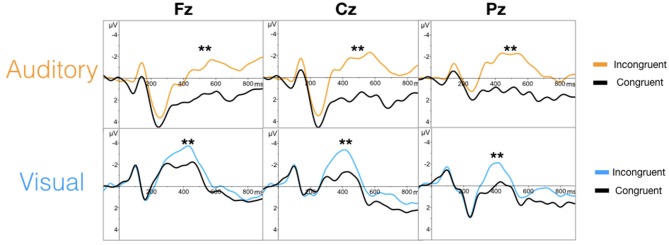
Grand averaged waveforms for the N400 (**) in the auditory (top) and visual (bottom) modalities.